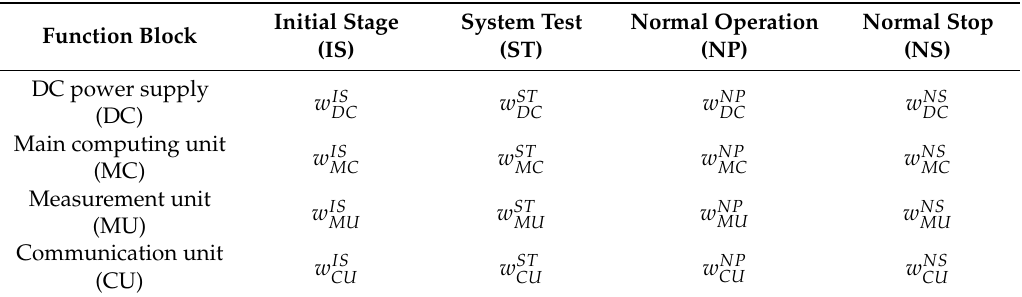
Table 1. Load weight of each major function block.